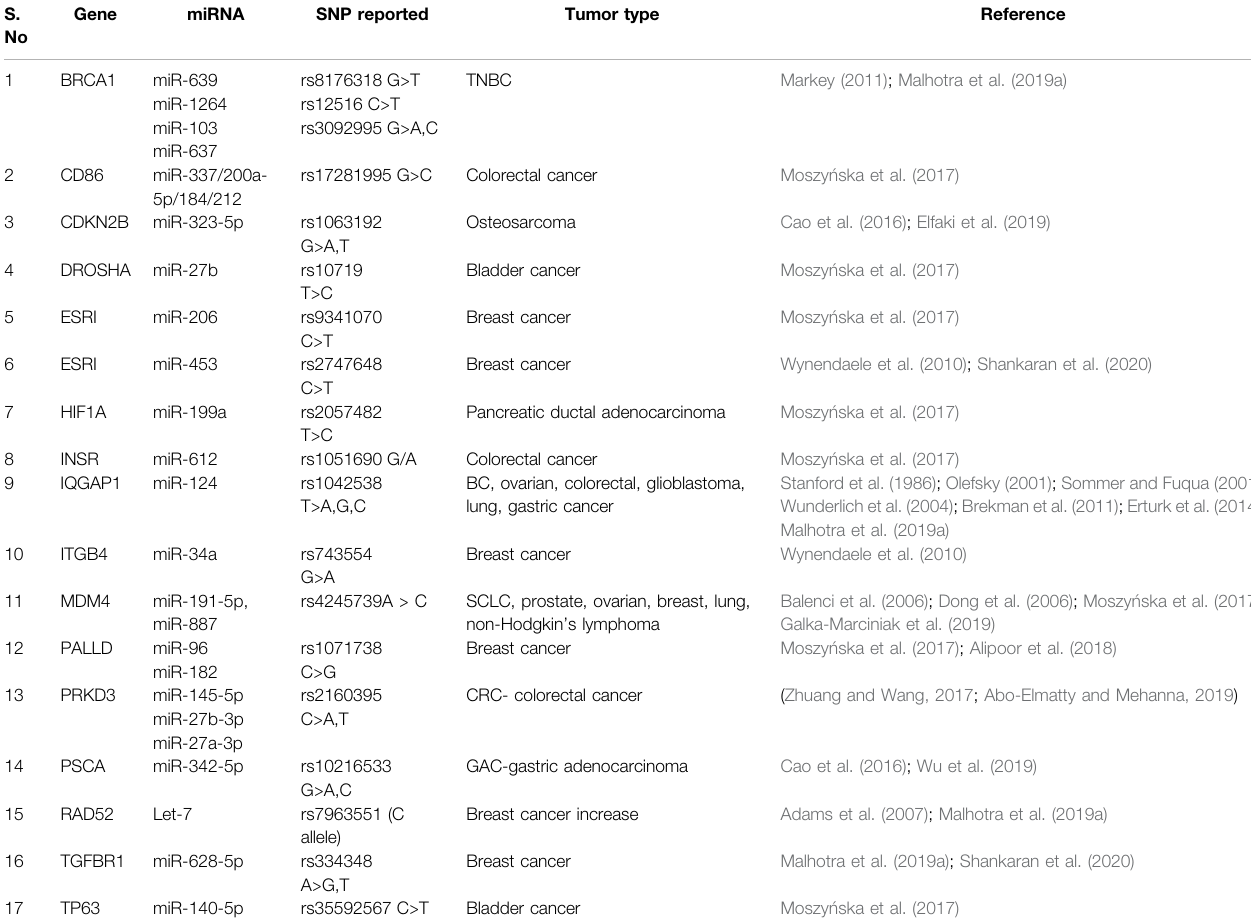
TABLE 2 | SNPs reported in target site of mi-RNA (mRNA-3 ′ UTR region) in